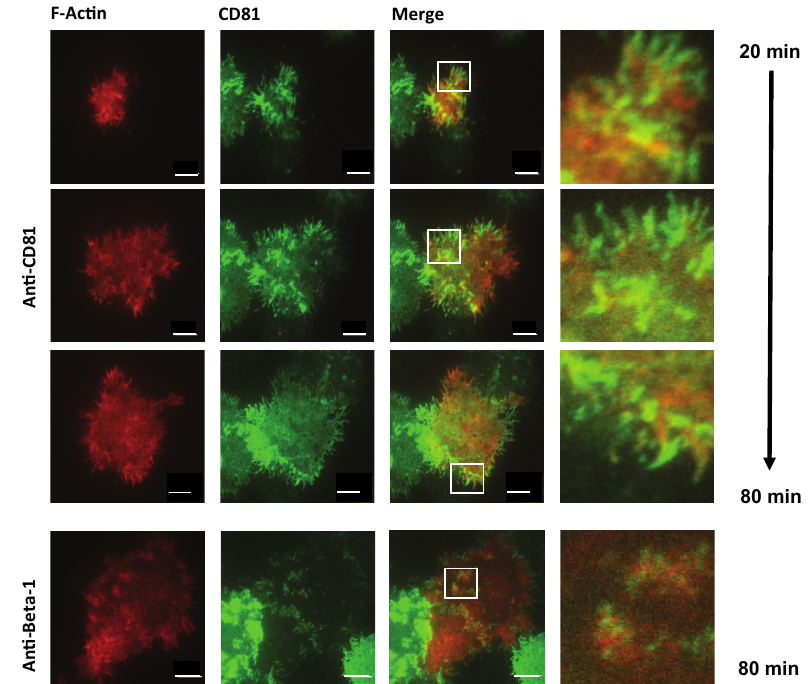
to express AcGFP.CD81 (green) and Ruby tagged LifeAct (red), were seeded onto glass bottom 35 mm dishes, coated with anti-CD81 (1s262) or anti-Beta-1. Images were collected by total internal reflection fluorescence (TIRF) microscopy every 10 min for a total of 80 min. Images depict CD81-Actin co-localization over time during cell adhesion and spread on anti-CD81 or anti-Beta-1 coated surfaces. Overlap coefficient R = 0.93 Anti-CD81 and R = 0.94 Anti-Beta-1 at 80 min; the data set is representative of two independent experiments. Scale bar represents 10